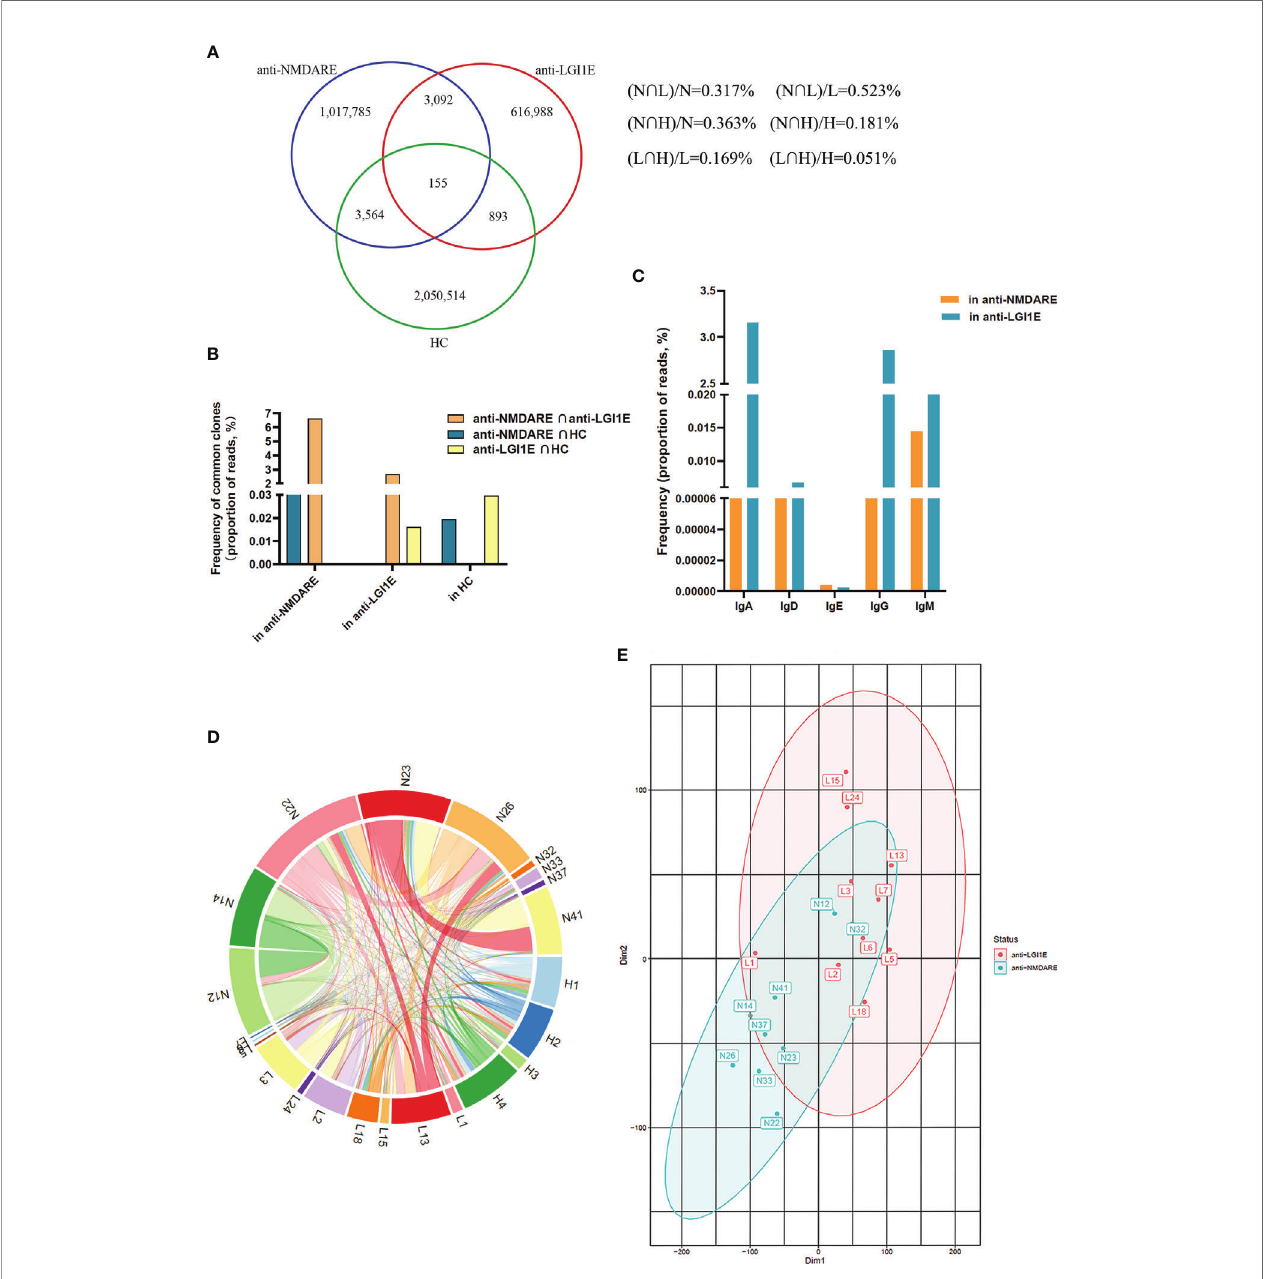
FIGURE 4 | Comparison of the similarity of the B-cell immune repertoire in peripheral blood samples from the anti-NMDARE, anti-LGI1E, and HC groups. (A) Number of common clones among the anti-NMDARE, anti-LGI1E, and HC groups in a Venn diagram. (B) The proportions of reads of common clones shared by each two groups of the anti-NMDARE, anti-LGI1E, and HC groups. (C) The result of frequency of common clones shared by the anti-NMDARE and anti-LGI1E groups for different isotypes (IgA/IgD/IgE/IgG/IgM) through analyzing the proportion of reads. (D) Number of common clones in each sample from the anti-NMDARE, anti-LGI1E, and HC groups in a circos plot; the area of each color represents the number of unique clones shared by two samples. (E) t -stochastic neighbor embedding plot of the BCR in samples from the anti-NMDARE and anti-LGI1E groups. Anti-NMDARE, anti-N-methyl-D-aspartate receptor encephalitis; anti-LGI1E, anti-leucine-rich glioma-inactivated 1 encephalitis; HC, healthy control; BCR, B-cell